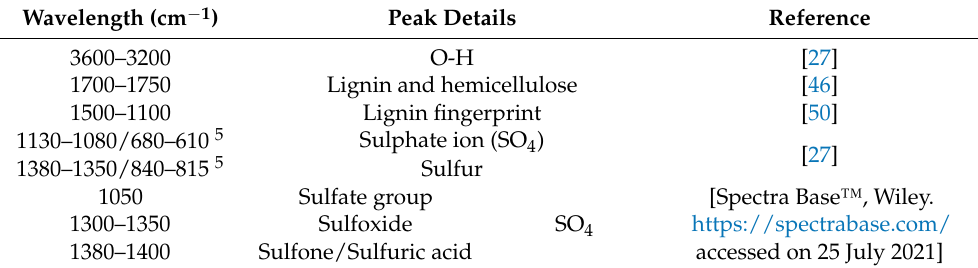
Table 4. Summary of important FTIR transmittance peaks in rot retardant (T1)-treated jute fibers.